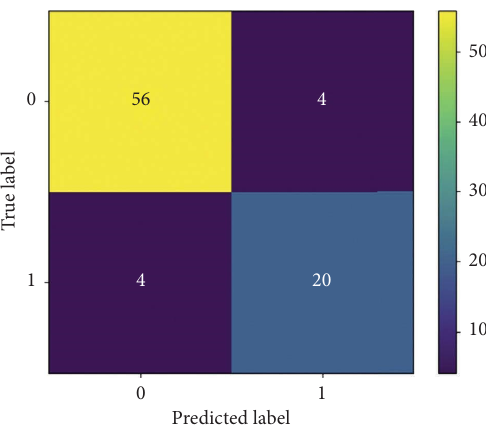
Figure 15: K-nearest neighbor classifcation confusion matrix.